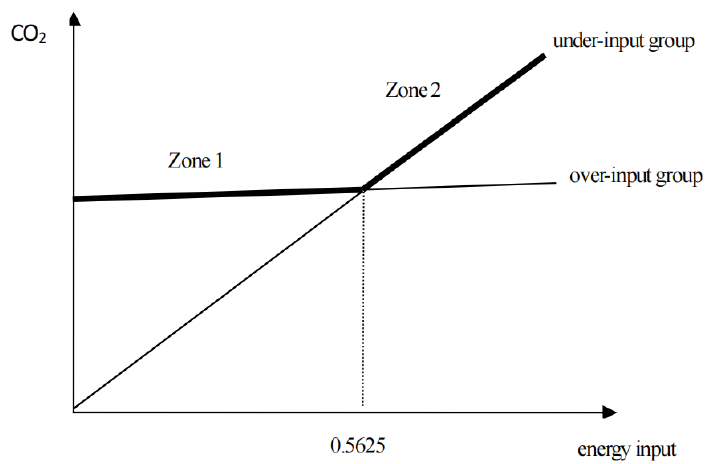
Figure 4. Differences in the relationship between energy input and CO 2 in different state